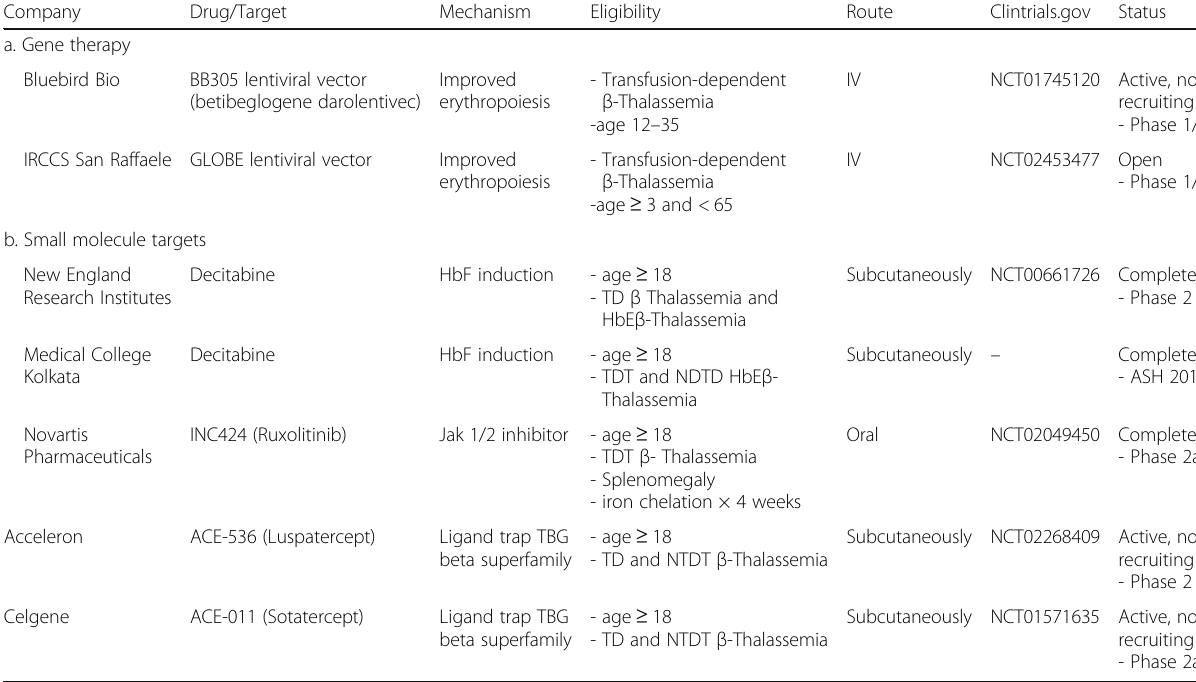
Table 2 Novel Therapeutics in β -Thalassemia Company